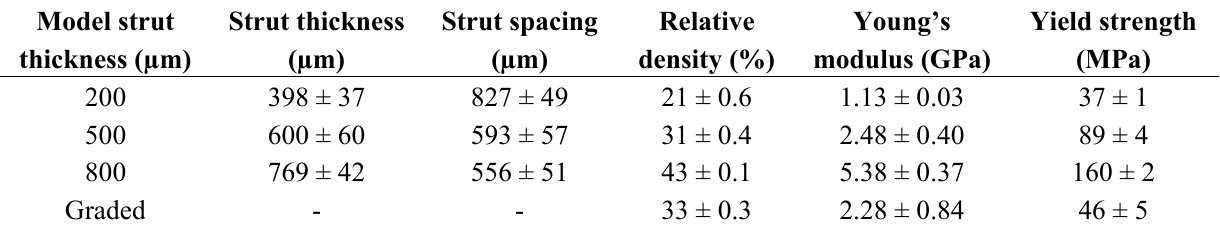
Table 1. Structural and mechanical properties of all lattices (Mean ±